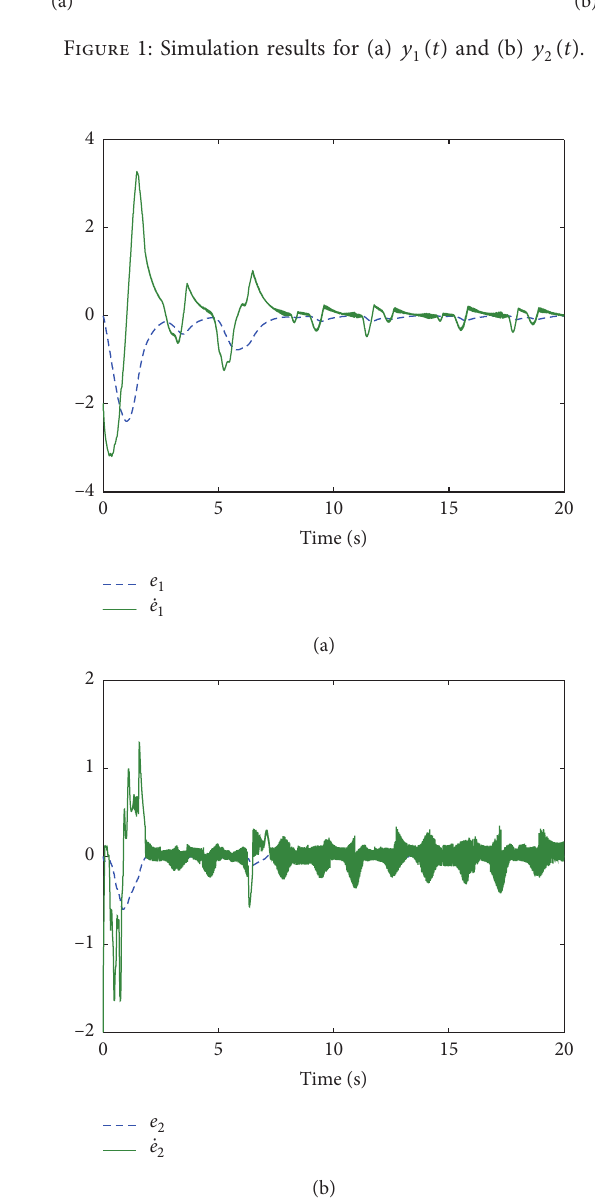
Figure 2: Tracking errors for (a) e